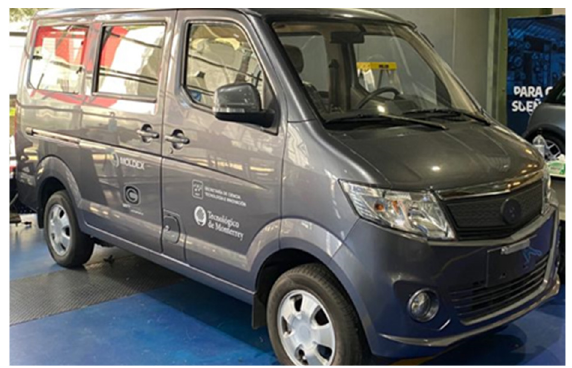
Figure 6. Test car for data gathering.